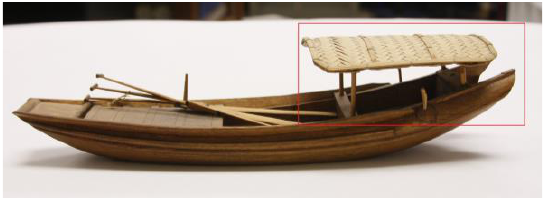
Figure 9. Small Junk with stern overhang outlined in red